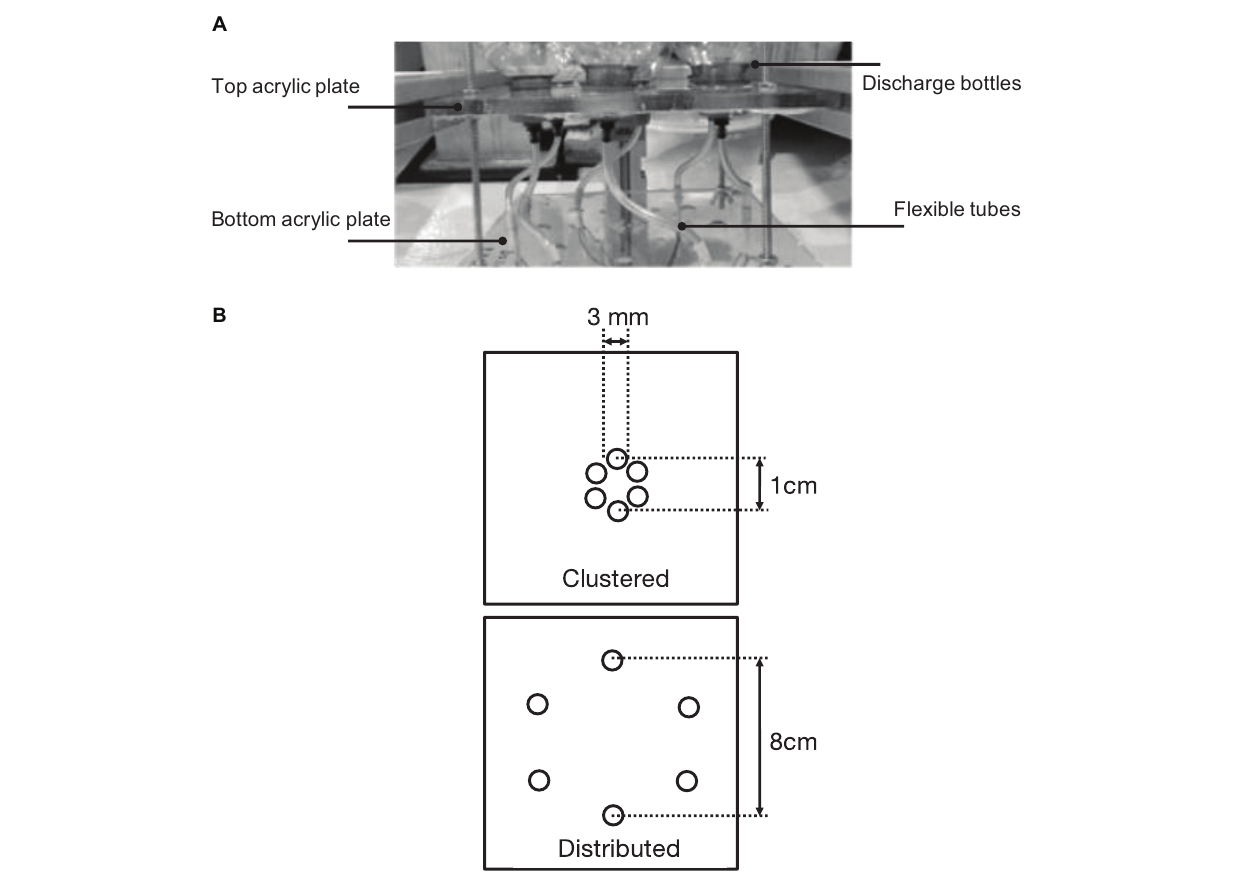
FIGURE 4 | (A) Glass beads dispensing device (Side view). (B) Discharge nozzle configurations: clustered and distributed sources. Both configurations consist of six equal-sized